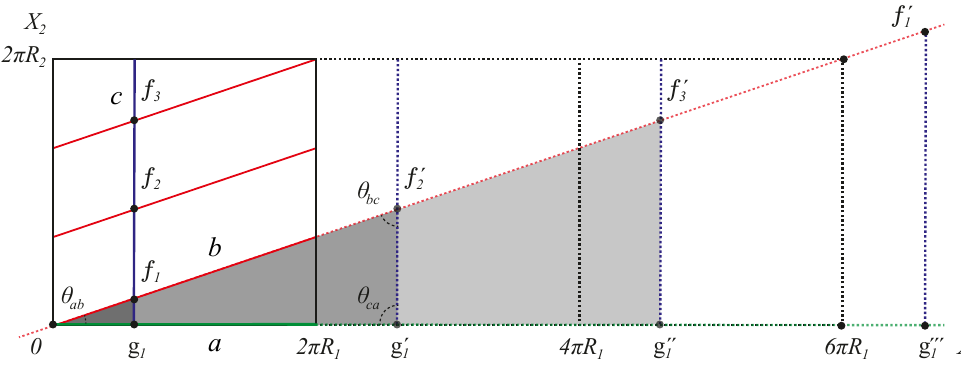
Figure 6 . A general intersecting D-branes configuration with three stacks of branes a , b and c intersecting in the i th 2 -torus T 2 of the internal space T 6 . The Higgs is assumed to live in the ab i sector, and the left and right-handed fermions in the bc and ac sectors. We write the angles as θ ab πa ab , with a ab [0 , 1] , and similarly for the other ≡ ∈